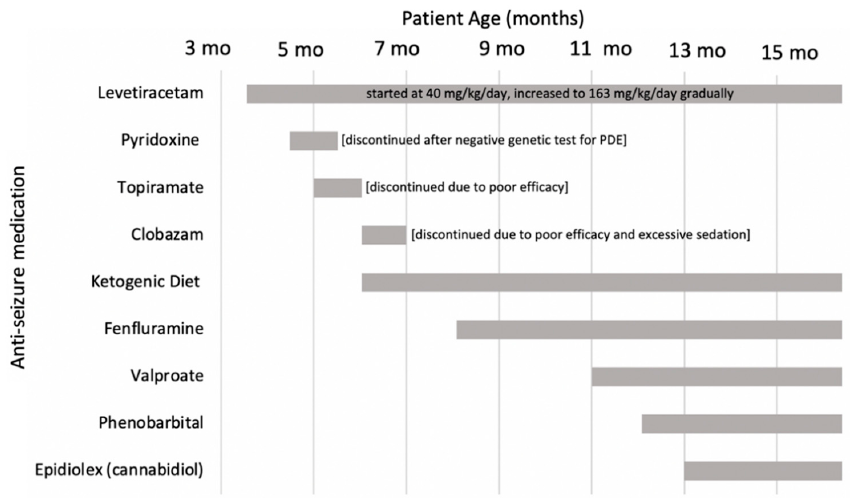
Figure 2. Timeline of initiating and/or discontinuing anti-seizure medications. PDE = pyridoxine- dependent epilepsy.